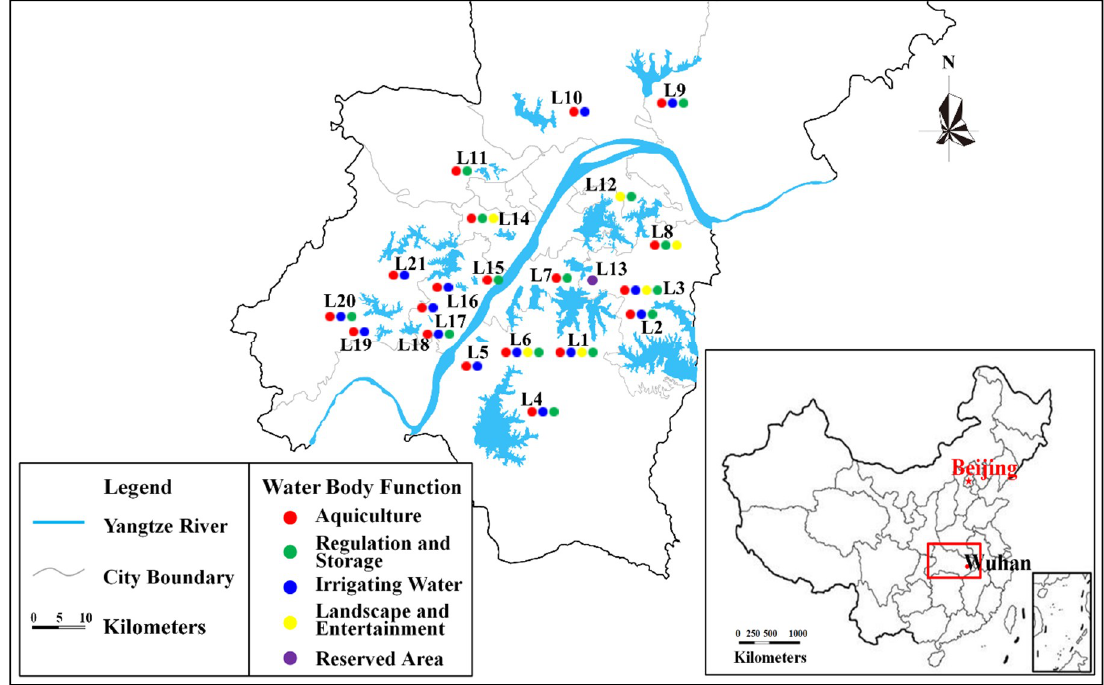
Figure 1. The geolocation of the 21 lakes in Wuhan (ArcGIS software version 9.3 (https://www.arcgis.